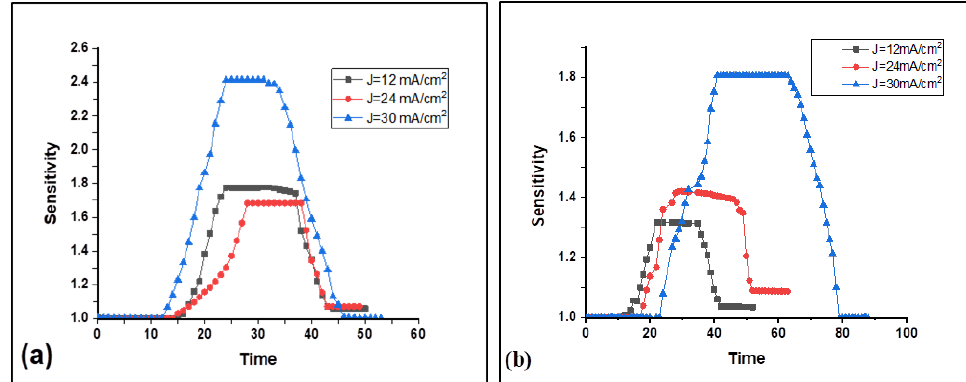
Figure 7: Typical gas sensor responses (Ra / Rg) to a PS with different etching current densities: 12, 24, 30 mA/cm 2 sensor for (a) acetone and (b)ethanol gases at an operating room temperature.